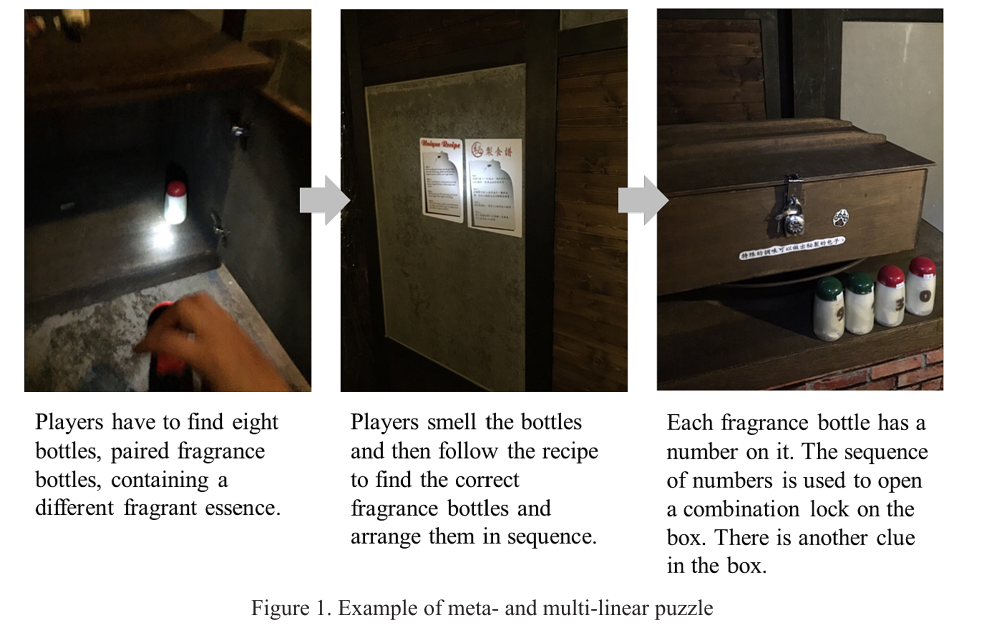
Figure 1. Example of meta- and multi-linear